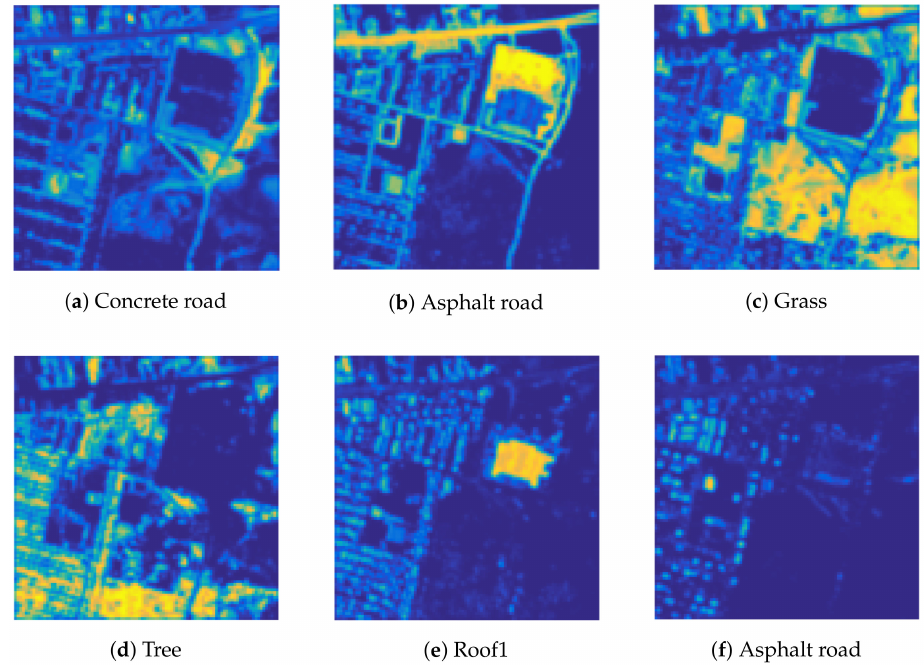
Figure 11. Abundances maps of each class: HYDICE urban